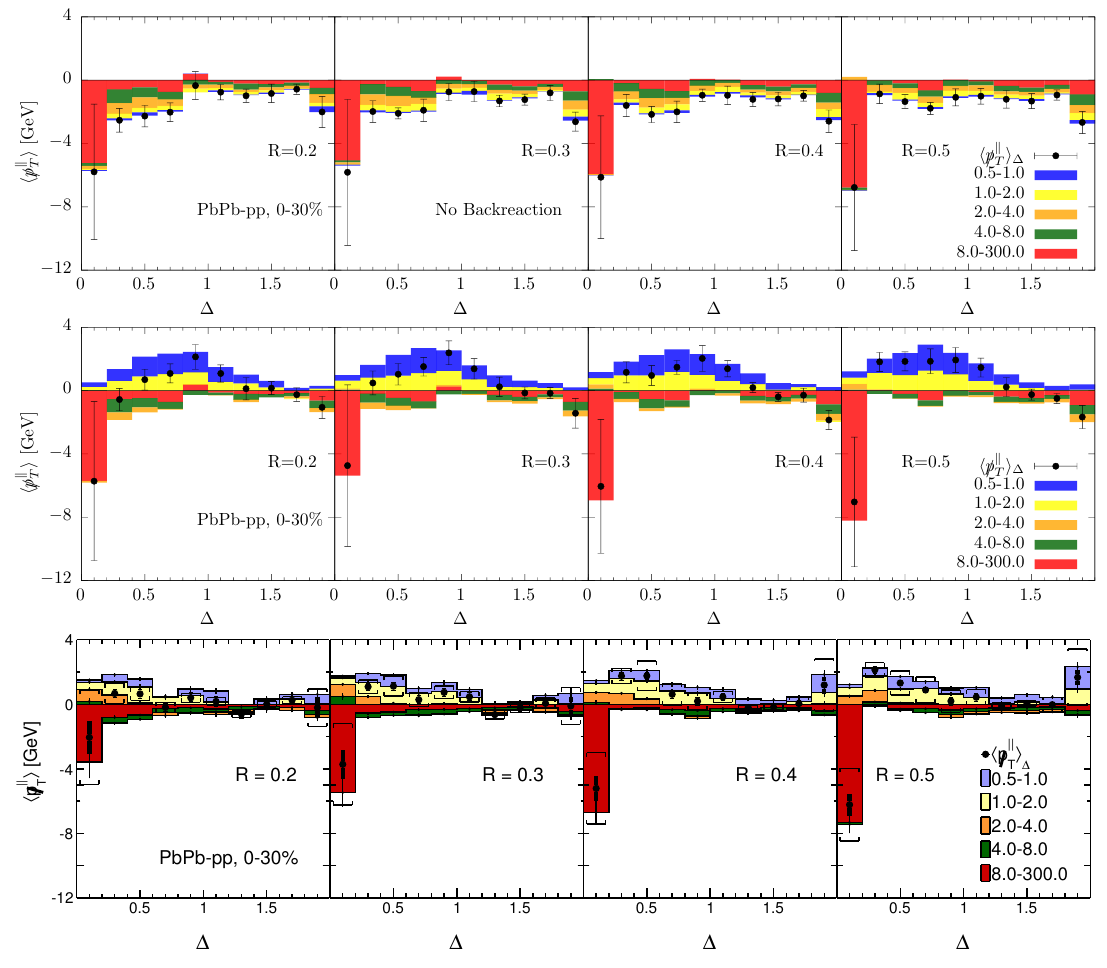
Figure 14 . Evolution in R of the missing =p k observable, A J inclusive and sliced in (cid:1), for the T di(cid:11)erence between PbPb and pp collisions. Top four panels are the results of our calculations with no contributions from the backreaction of the medium. Middle four panels are the results of our full calculations, in which the =p k imbalance in hard particles due to jet quenching is balanced by that in T soft particles coming from the wakes of the two jets. The R = 0 : 3 panels are the di(cid:11)erence between the PbPb results shown in (cid:12)gure 12 and the same for proton-proton collisions. Bottom four panels come from the analysis of experimental data by the CMS collaboration reported in ref. [60].